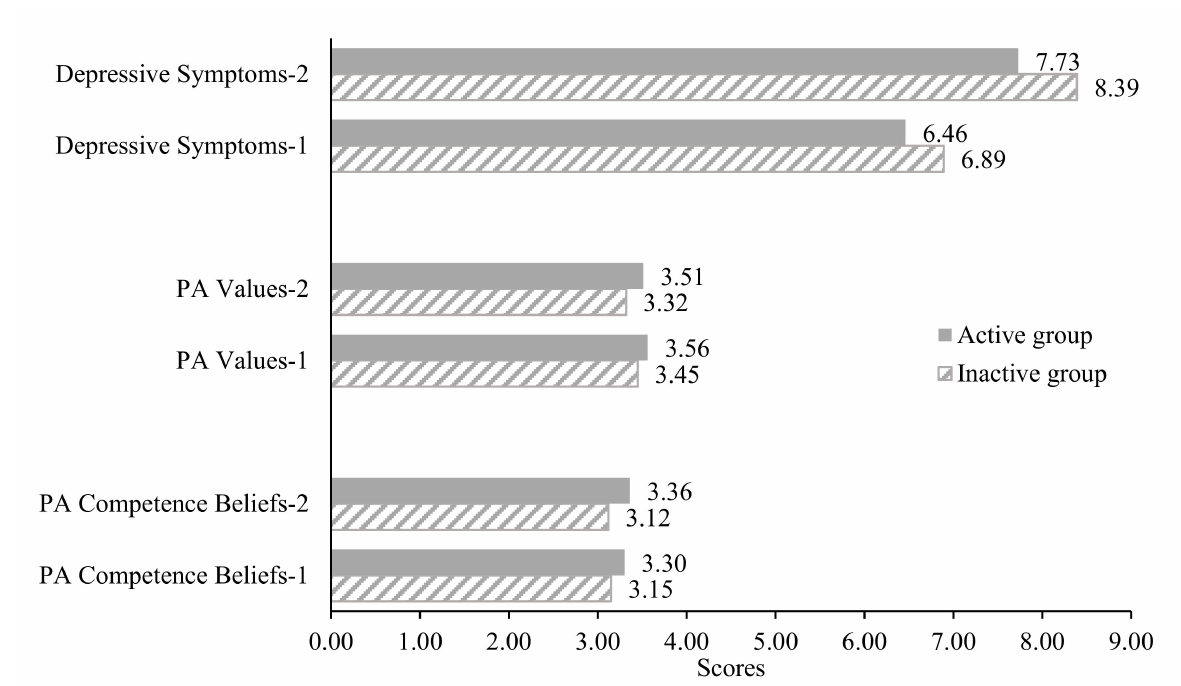
Figure 1. Active and Inactive Group differences in PA motivations and depressive symptoms over time. Note. Group Effect (Active vs. inactive): Wilks’ lambda = 0.977, F (3, 976) = 7.79, p < 0.001, η 2 = 0.023; observed power = 0.989). Time 1 measures and all covariates (i.e., age, gender, major, and BMI) were